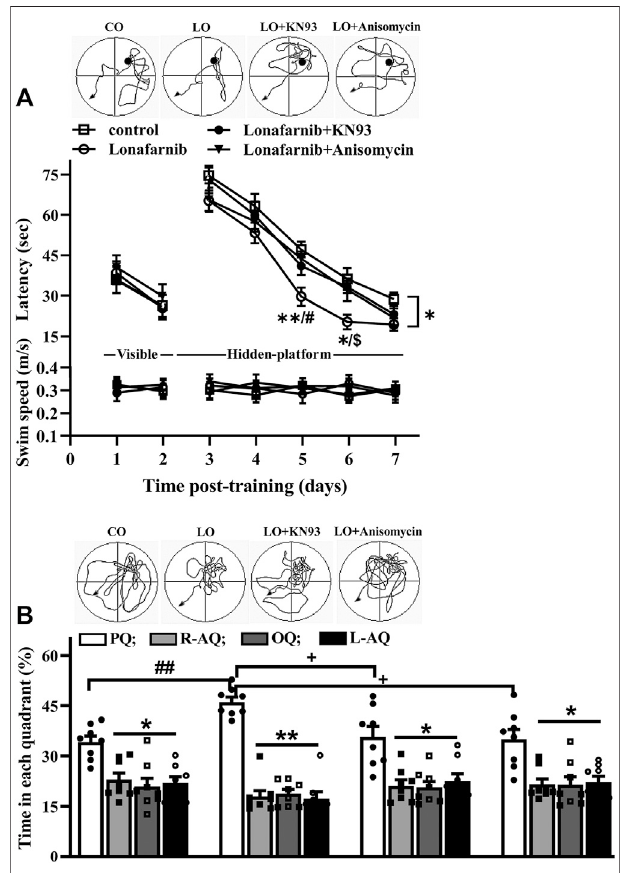
FIGURE 6 | Lonafarnib treatment improves spatial learning memory. (A) Latency (sec) to reach visible platform and hidden platform of Morris water maze in control mice (control), lonafarnib-treated mice (lonafarnib), lonafarnib + KN93-treated mice (lonafarnib + KN93), and lonafarnib + anisomycin- treated mice (lonafarnib + anisomycin). Tracings of typical swim patterns in hidden platform task (upper panels). Black circles indicate the position of platform. * P < 0.05, and ** P < 0.01 vs. control mice, # P < 0.05 vs. Lonafarnib + anisomycin-treated mice, $ P < 0.05 vs. lonafarnib + KN93-treated mice (repeated-measure ANOVA, followed by Tukey ’ s multiple comparison test). (B) Percentage of swim time (%) in quadrants of platform (PQ), opposite (OQ) and right/left adjacent (R-AQ, L-AQ) in Morris water maze. Tracings of typical swim patterns inprobe task (upperpanels).** P < 0.01and * P < 0.05vs. swimtime in PQ (comparison within group, repeated-measure ANOVA, followed by Dunnett ’ s multiple comparison test), ## P < 0.01 vs. control mice, + P < 0.05 vs. lonafarnib+KN93-treatedmiceor+anisomycin-treatedmice(one-wayANOVA, followed by Tukey ’ s multiple comparison test).